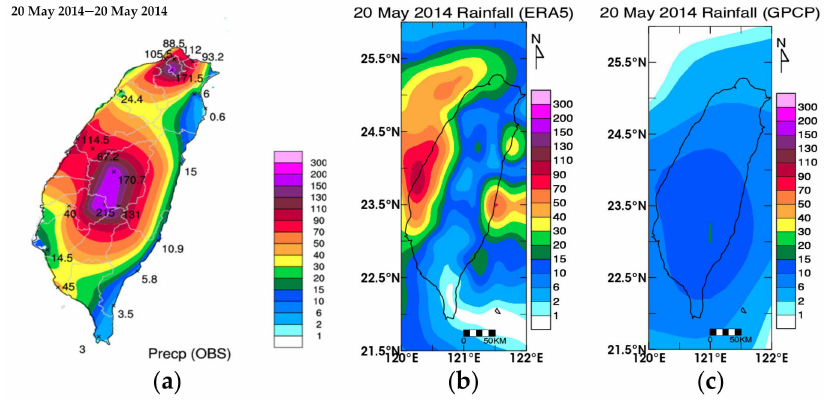
Figure 3. Time-series of station precipitation (green bar) and ERA5 precipitation (red bar) from 1 May to 30 June in 2014.